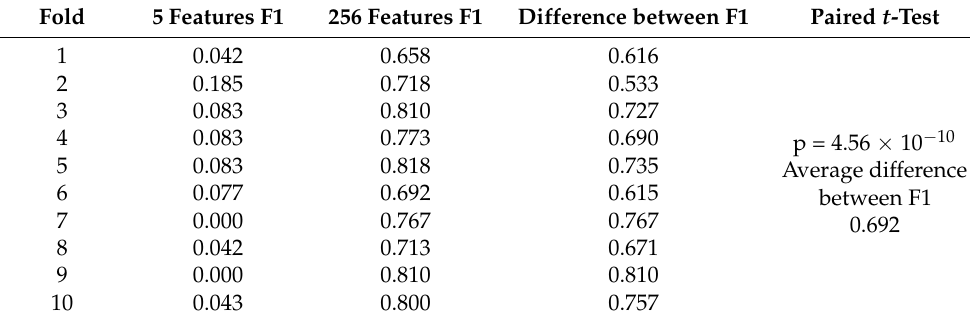
Table 10. Paired t -test of F1-score for 256 features vs. 258 features. Fold